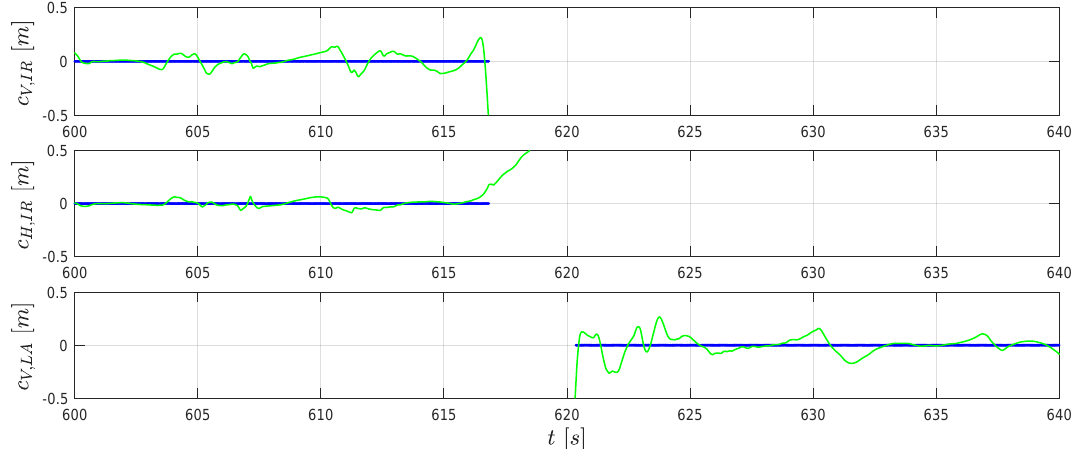
Figure 10. The extended RTS smoother estimated geometric constraints c (green line) and pseudo measurements (blue dots).